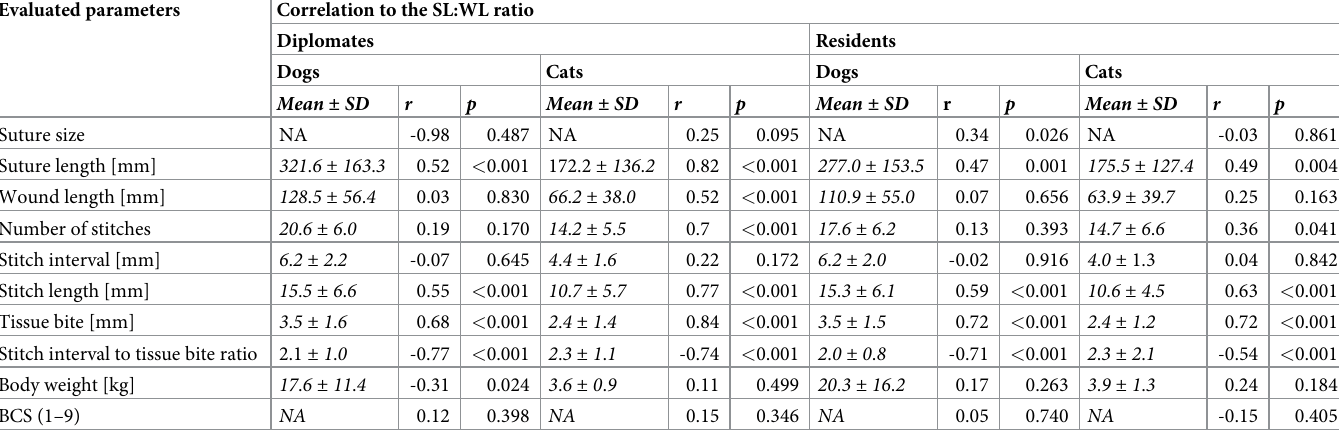
Table 5. Correlation between the SL:WL ratio and different parameters separated by groups and species. Evaluated parameters Correlation to the SL:WL ratio Diplomates Residents